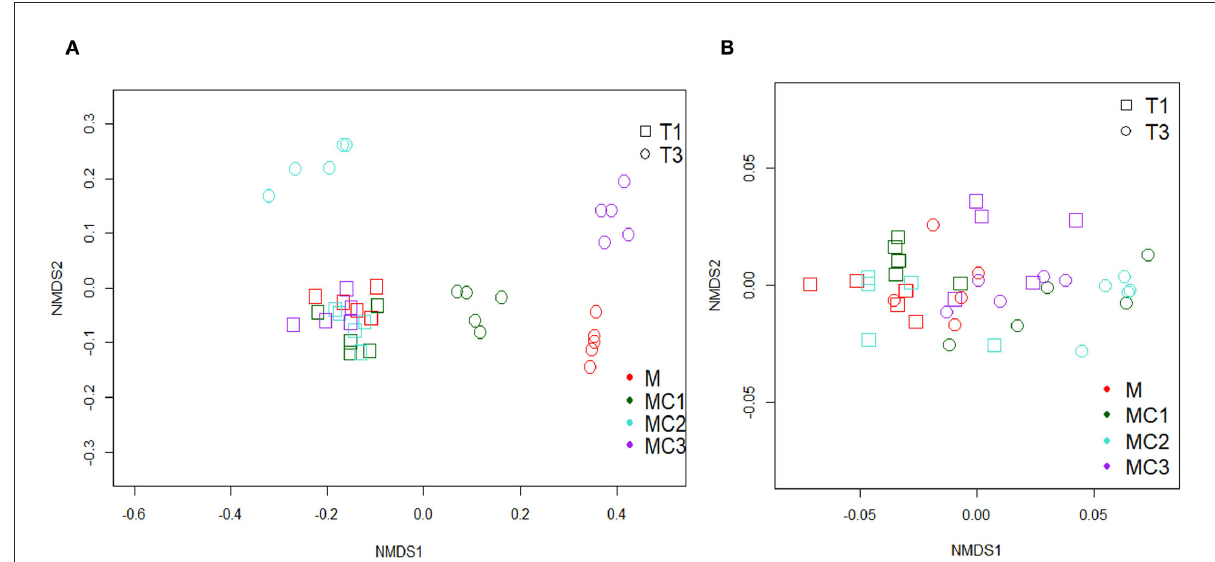
FIGURE5 A Non-metric Multi-dimensional Scaling (NMDS) of predicted nitrogen cycle genes (A) and predicted carbon cycle genes (B) M, melon monocrop; MC1, mixed intercropping; MC2, intercropping row 1:1 melon:cowpea; MC3, intercropping row 2:1 melon:cowpea; T1, First year; T3, Third